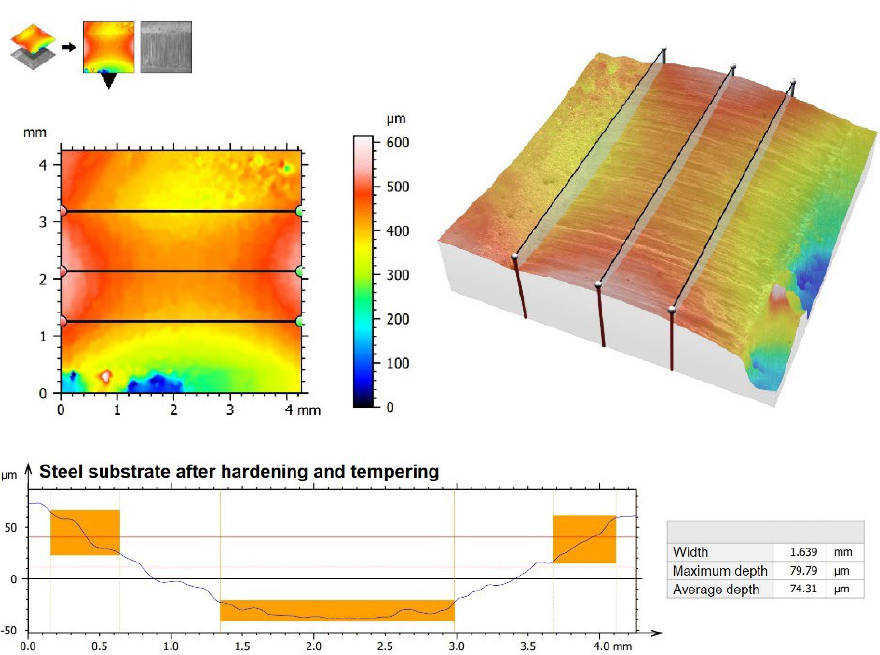
Figure 11. The 3D wear profiles obtained after the wear resistance test of the substrate after hardened and tempered processes.